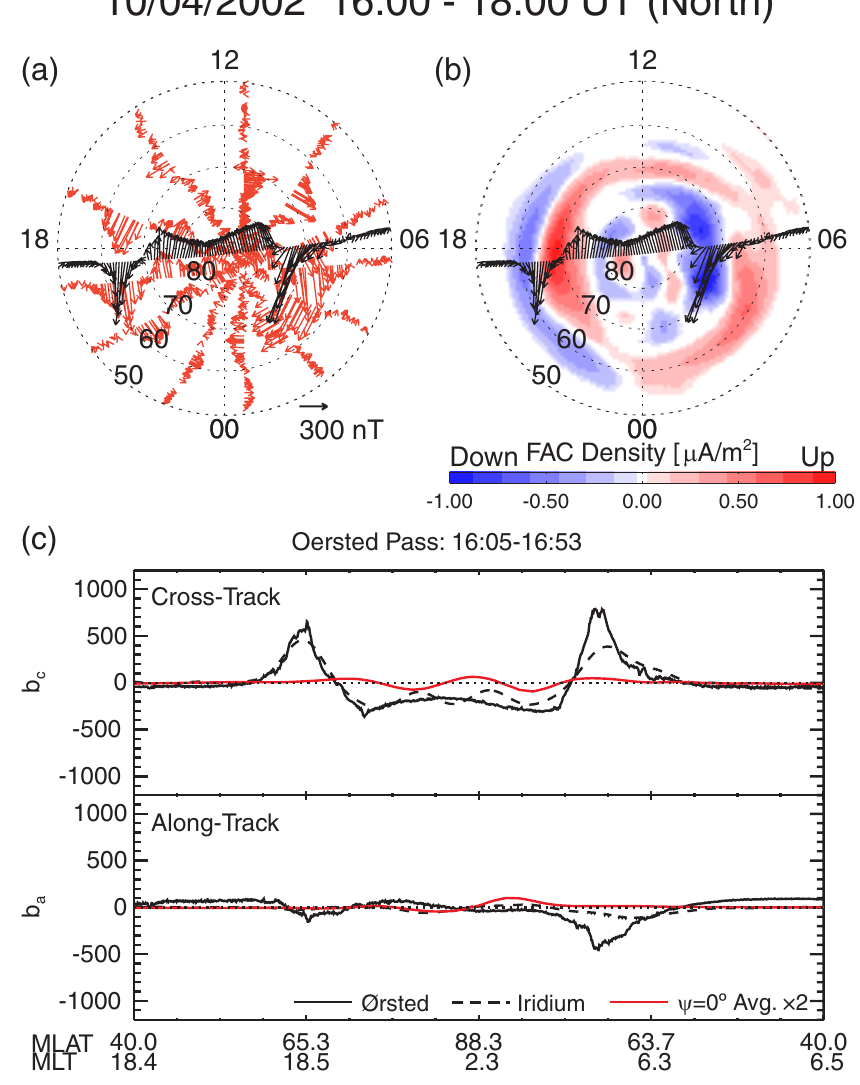
Fig. 8. Ørsted and Iridium observations for a southward IMF event from 4 October 2002 in the same format as Fig. 6. Iridium data are from 1600 to 1800 UT and Ørsted data are from the northern hemisphere pass from 1605 to 1653 UT. The red traces in panel (c) are the psi = 0 Iridium statistical result evaluated along the Ørsted track multiplied by two and are shown to indicate the signatures that would have been anticipated for NBZ-like polar cap currents. Average solar wind and IMF conditions for this interval are given in Table 3